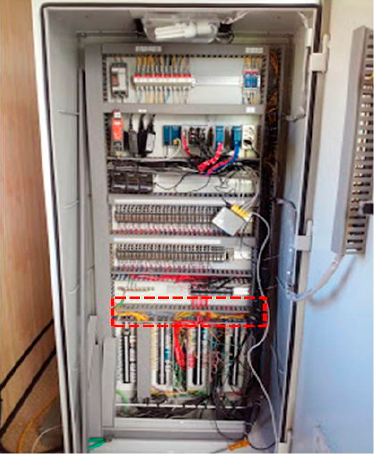
Figure 12. Installed current measuring equipment.